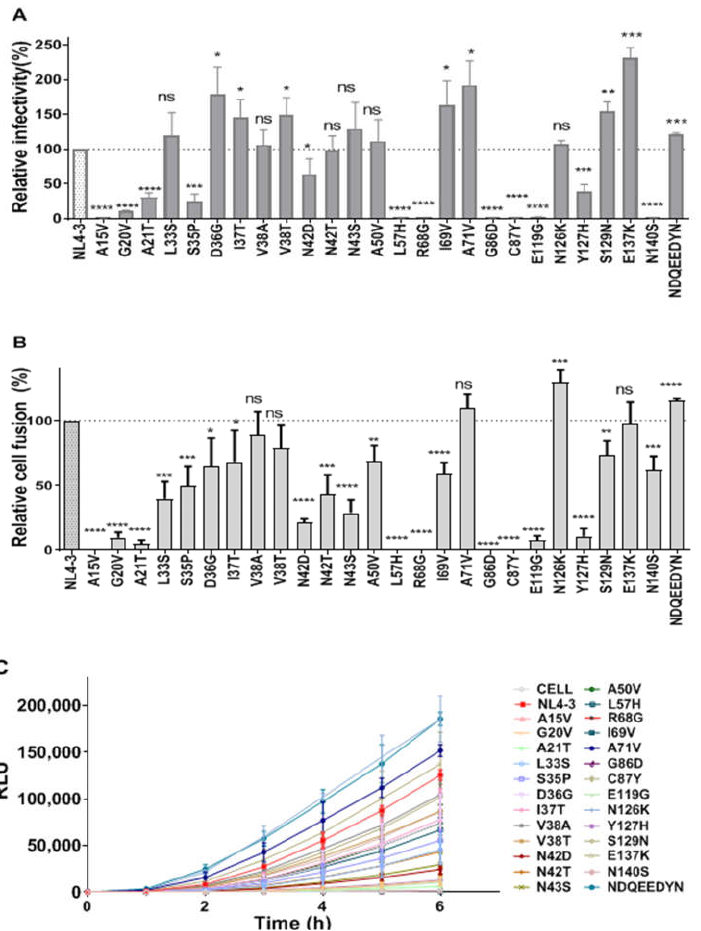
Figure 6. Effects of T20- and LP40-induced mutations on the functionality of HIV-1 Env. ( A ) Relative infectivity of HIV-1NL4-3 and its mutants, determined using a single-cycle infection assay. ( B ) HIV-1 Env-mediated cell–cell fusion, determined using a dual split-protein assay (DSP). For both entry and fusion data, the luciferase activity of wild-type HIV-1NL4-3 (WT) was treated as 100%, and the relative activities of other mutant viruses were calculated accordingly. The experiments of infectivity and fusion were repeated three times, and these data are expressed as means with SD. A t -test was performed to judge the significance of the difference between the WT and the mutants. *, p < 0.05; **, p < 0.01; ***, p < 0.001; ****, p < 0.0001; ns, not significant). ( C ) Kinetics of the HIV-1 Env-mediated cell–cell fusion, determined using a DSP-based assay. 2.7. Cross-Resistance to T20 and LP40 of Single-Point Mutations on Pseudoviruses As shown, the point mutations A15V, L57H, R68G, G86D, C87Y, E119G, and N140S caused significant reductions in the viral entry activity, and viral titers were insufficient for the later evaluation of the drug activity for T20 and LP-40. As shown in Table 2, 18 other point-mutant pseudoviruses were evaluated for T20 and LP-40 sensitivity, respec- tively. Six point-mutant pseudovirus (L33S, I37T, V38A, V38T, N42T, and N43S) showed resistance to T20, with IC 50 in the range of 0.41–3.4 µM and a 6–51-fold decrease in sensi- tivity. Similarly, these six mutant pseudoviruses also showed resistance to LP-40, with